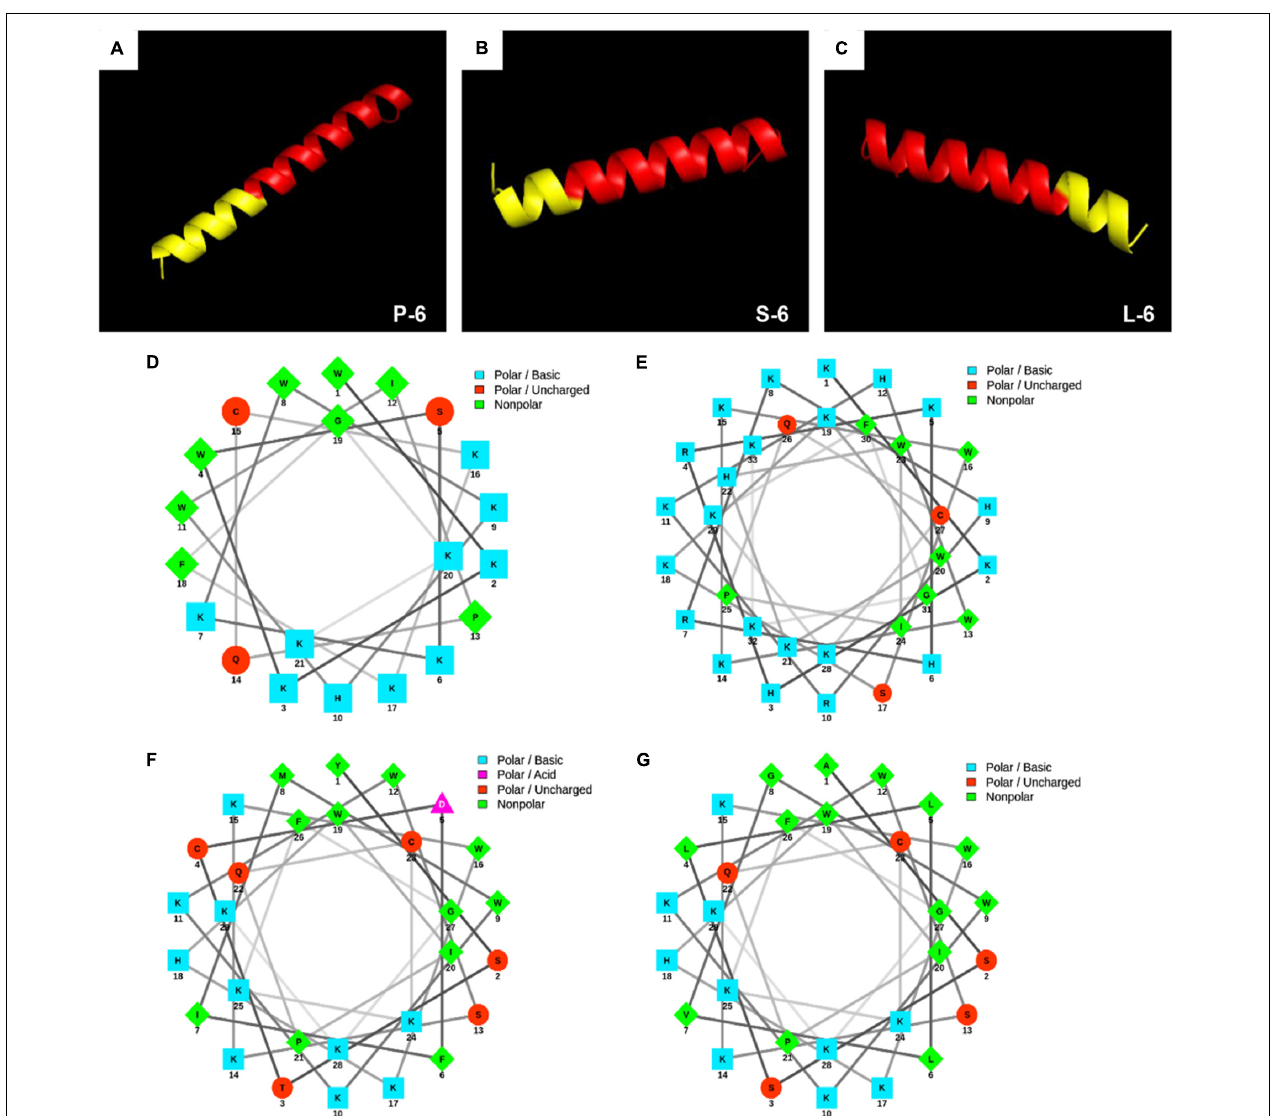
FIGURE 1 | 3D molecular modeling and helical wheel projections of antimicrobial peptides. 3D molecular modeling of P-6 (A) , S-6 (B) , and L-6 (C) . The red section represents antimicrobial peptides 1–6, and the yellow section represents the added targeted fragment. Helical wheel projections of 1–6 (D) , P-6 (E) , S-6 (F) , and L-6 (G) . In the spiral wheel projection, hydrophilic residues appear as circles, hydrophobic residues as diamonds, possibly negatively charged residues as triangles, and possibly positively charged residues as squares. Hydrophobicity is also indicated by color: the most hydrophobic residues are green, hydrophilic residues are red, positively charged ones are blue, and negatively charged ones are